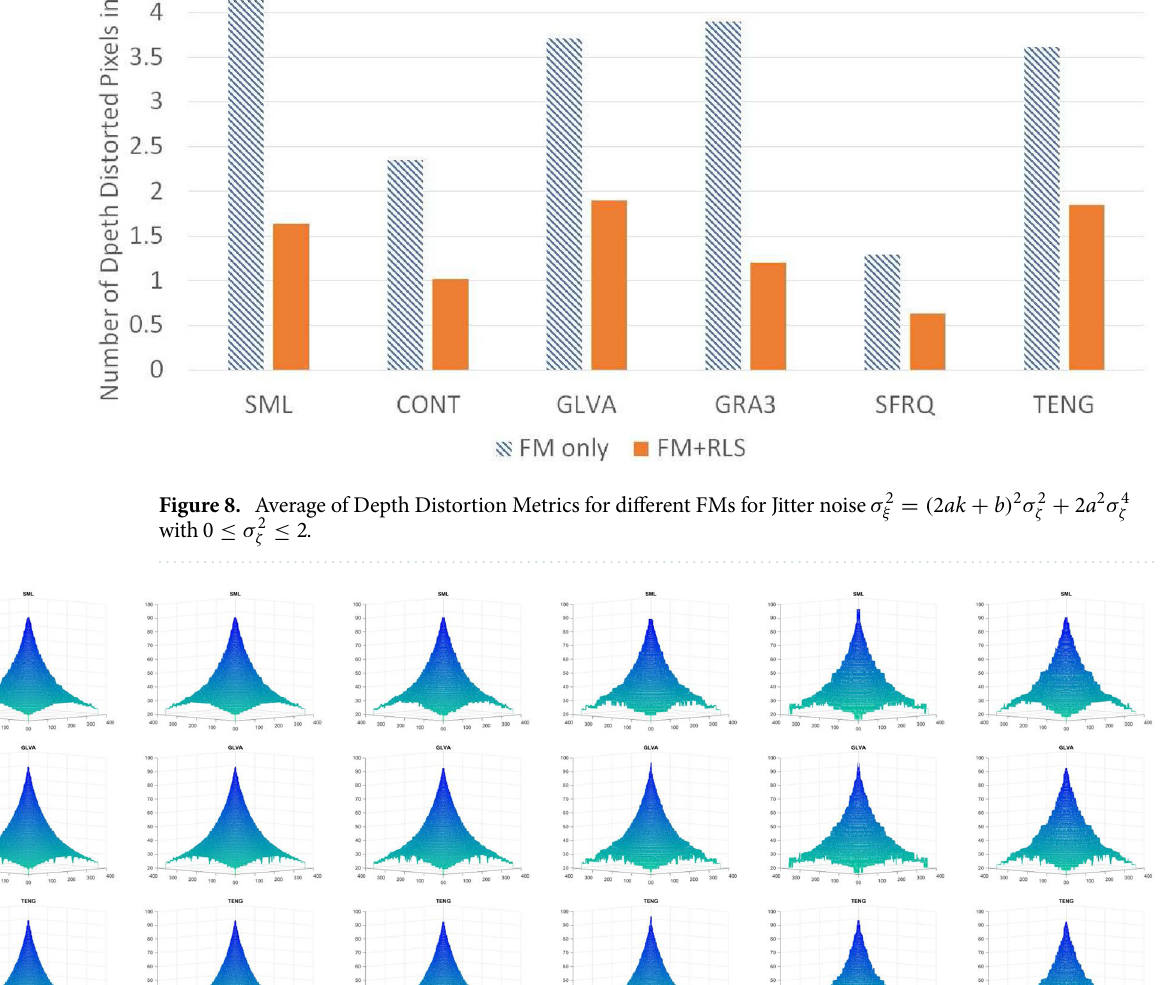
Figure 9. Shape reconstruction for simulated cone, using FM with proposed RLS method. (left to right) SML, GLVA, TENG. (top to bottom) σ 2